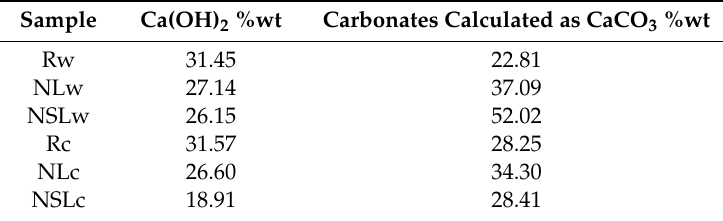
Table 4. Calcium hydroxide and carbonate species content, as a percentage by mass, at 28